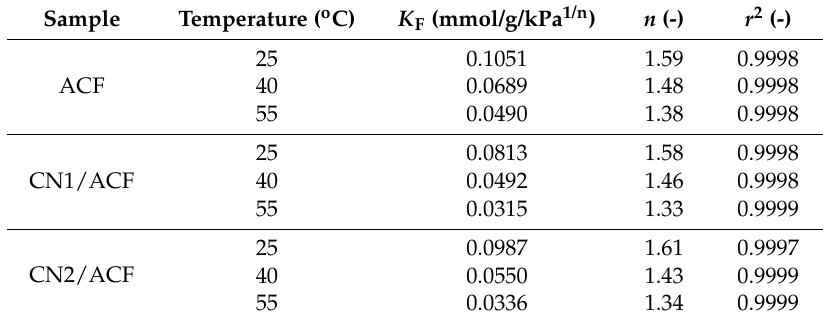
Figure 7. The isosteric enthalpy of the adsorption of CO 2 on all samples: ( a ) as-received activated carbon fibers (ACF); ( b ) ACF grafted with N-doped carbon nanotubes (CN1/ACF); ( c ) ACF pre-immersed with cobalt(II) acetate and grafted with N-doped carbon nanotubes (CN2/ACF). The CO 2 adsorption capacity and Q st were different depending on the sample. The reason could be the residue of the catalysts for the growth of CNs. Since the as-received CN1/ACF and CN2/ACF